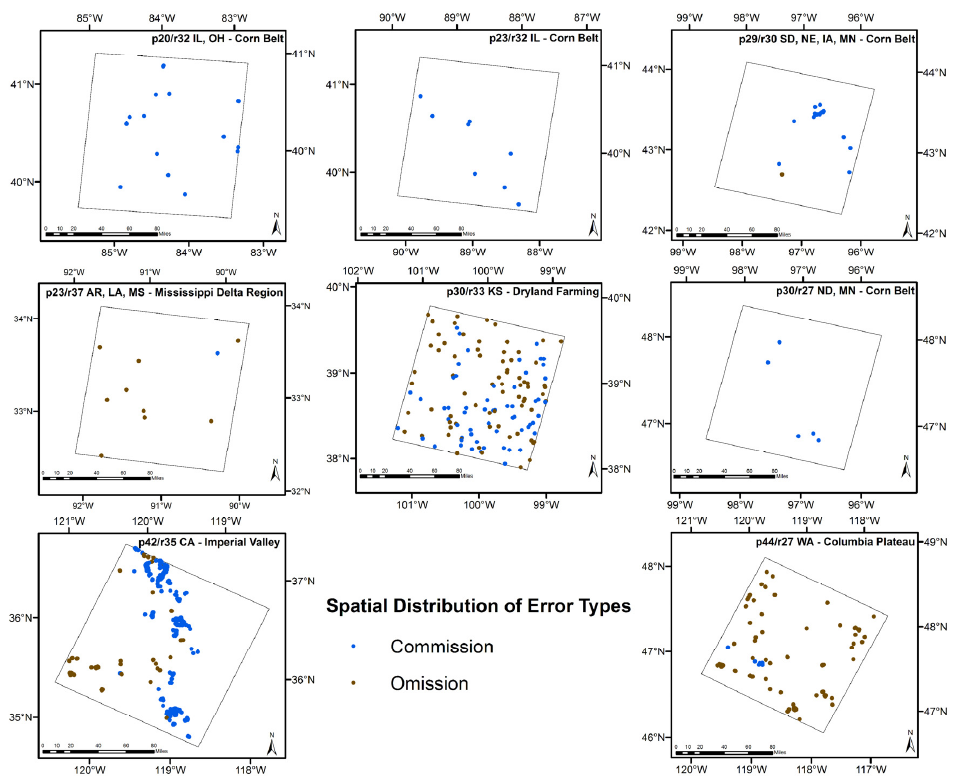
Figure 6. Spatial location of pixels identified as commission and omission for the cultivated crops in NLCD 2006. Commission error samples are represented in blue and omission error samples are represented in brown. The symbols used in this figure (row 2 columns 2) are not to proportion but for illustration purposes only.